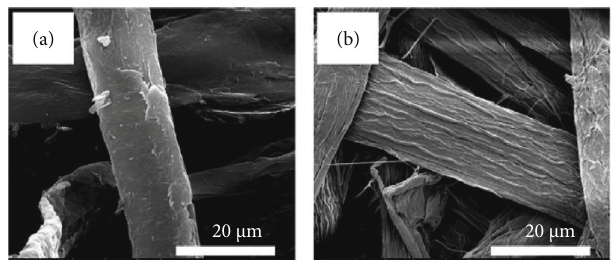
Figure 4: SEM micrograph: (a) untreated bamboo cellulose and (b) NaOH-treated bamboo cellulose fi ber. (Reproduced with permission from Elsevier, license number: 5191770249047)